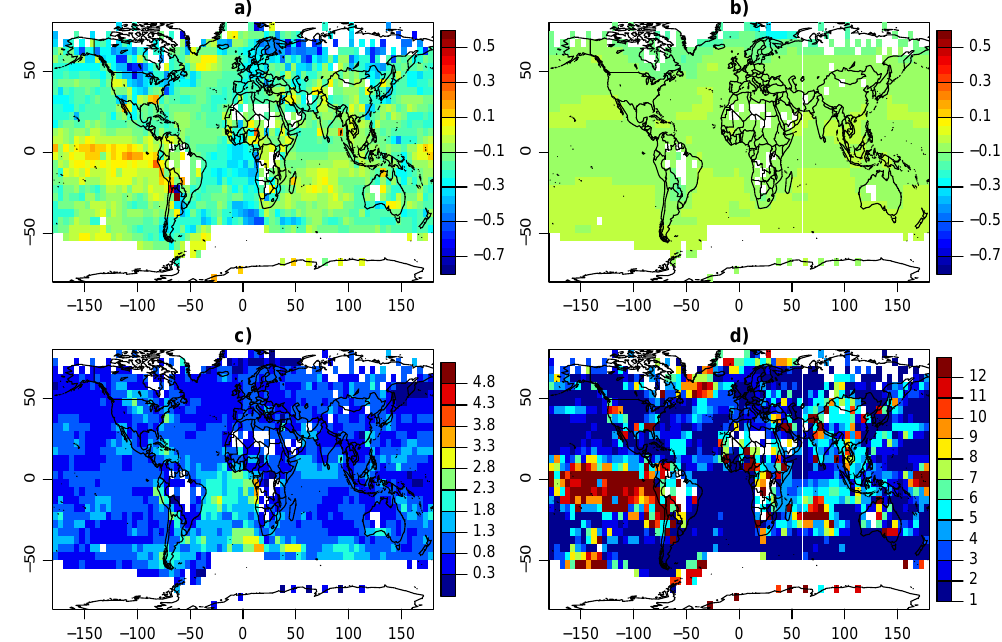
Fig. 7. Global fields of decadally smoothed temperature: (a) reconstructed mean anomaly map for a cold period (for the 1390s to 1690s), (b) ensemble-mean simulated anomaly map for the same period, (c) ensemble mean of relative standard deviations (reconstruction standard deviation divided by simulation standard deviation at each grid-point for the full period), (d) mapped target ranks for evaluating SIM against the target for the cold period (1390s to